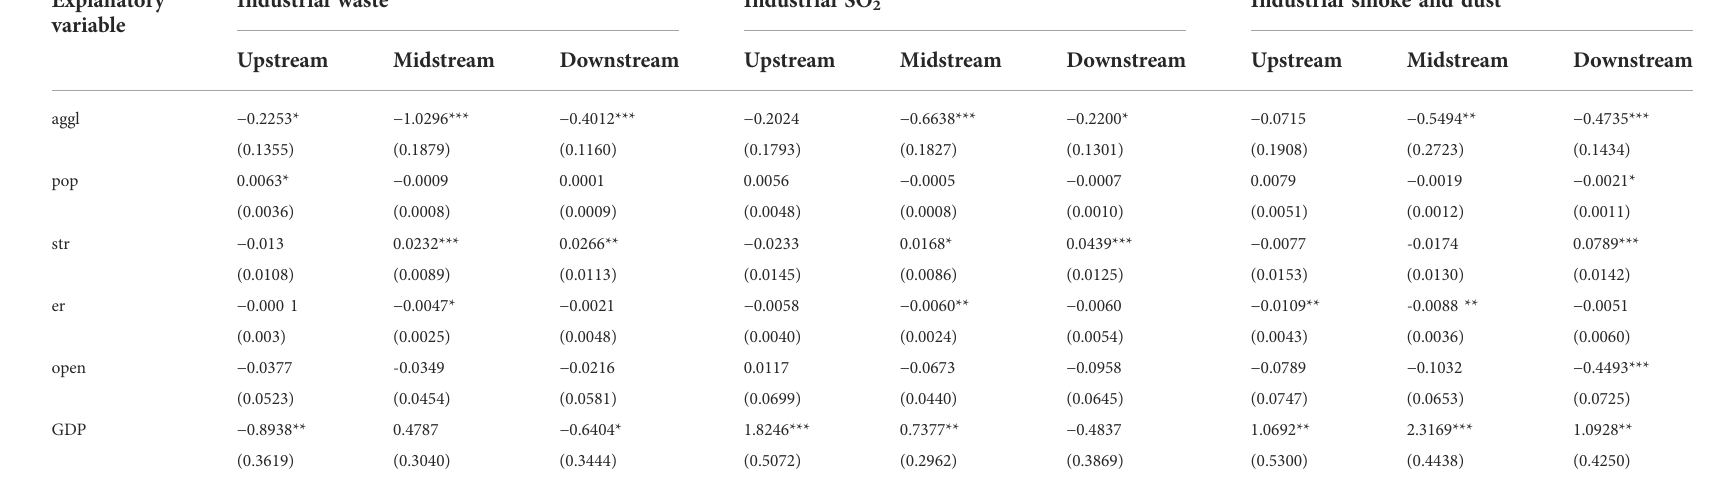
TABLE 4 Regression results of the impact of industrial agglomeration on industrial pollution in the upper, middle, and lower reaches of the Yellow River